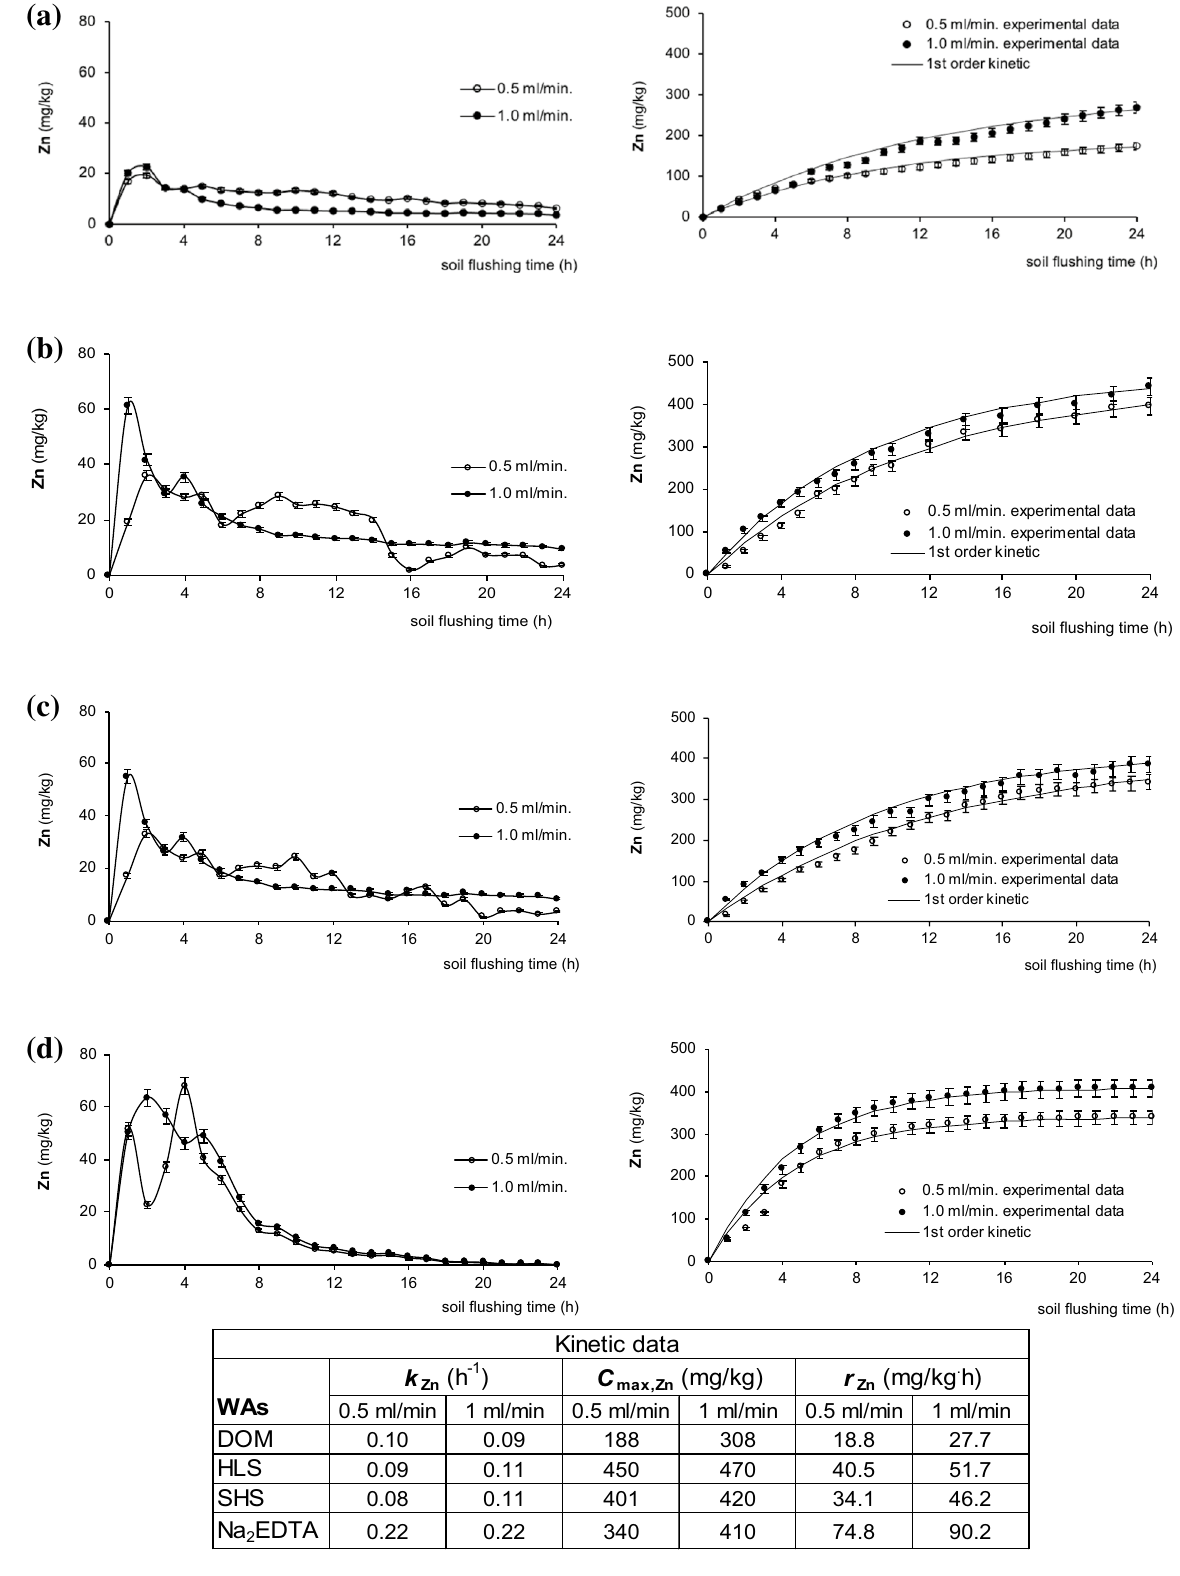
Figure 7. Zn mobilization curves and its cumulative removal during soil flushing at two flow rates with DOM ( a ), HLS ( b ), SHS ( c ), Na 2 EDTA ( d ) with kinetic constants. Data are expressed as mean values (n = 2) ± standard deviation error